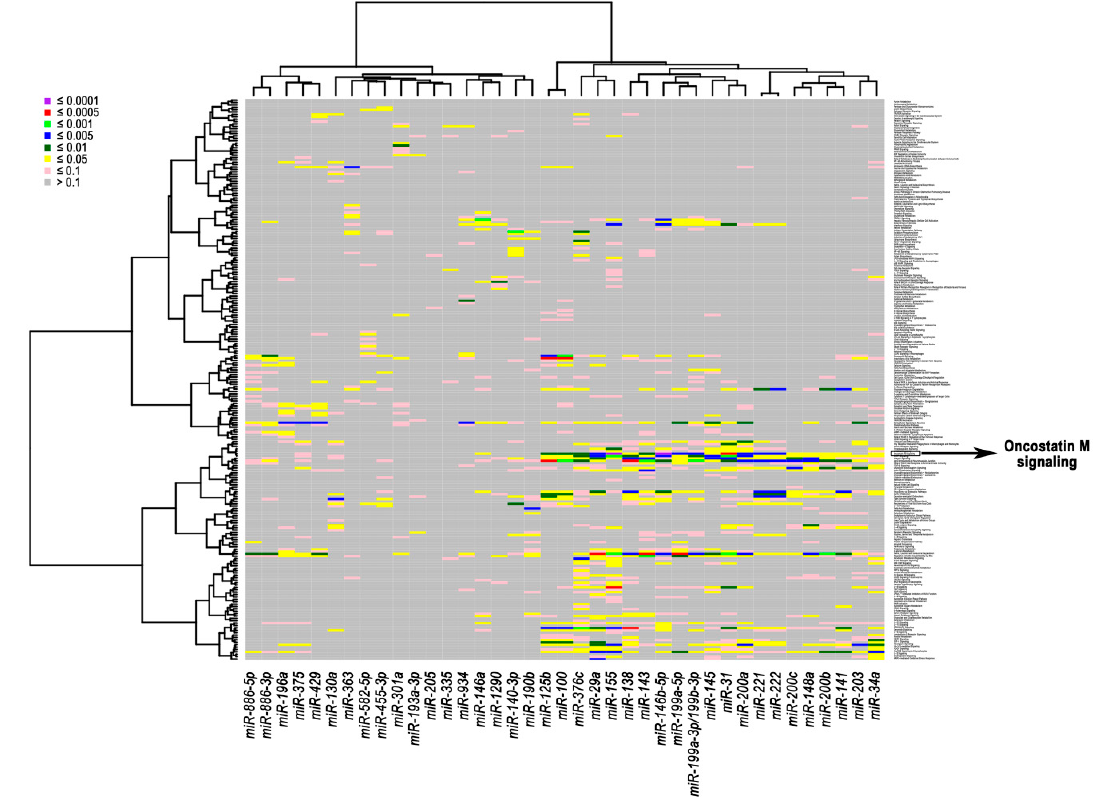
Figure 3. Heatmap of association between correlated miRNAs-mRNAs and signaling pathways in breast cancer cell lines. The heatmap was generated using the expression levels of the 39 selected miRNAs and correlated mRNAs. The miRNA-pathway associations were computed and displayed with eight color levels corresponding to different false discovery rate (FDR) levels.